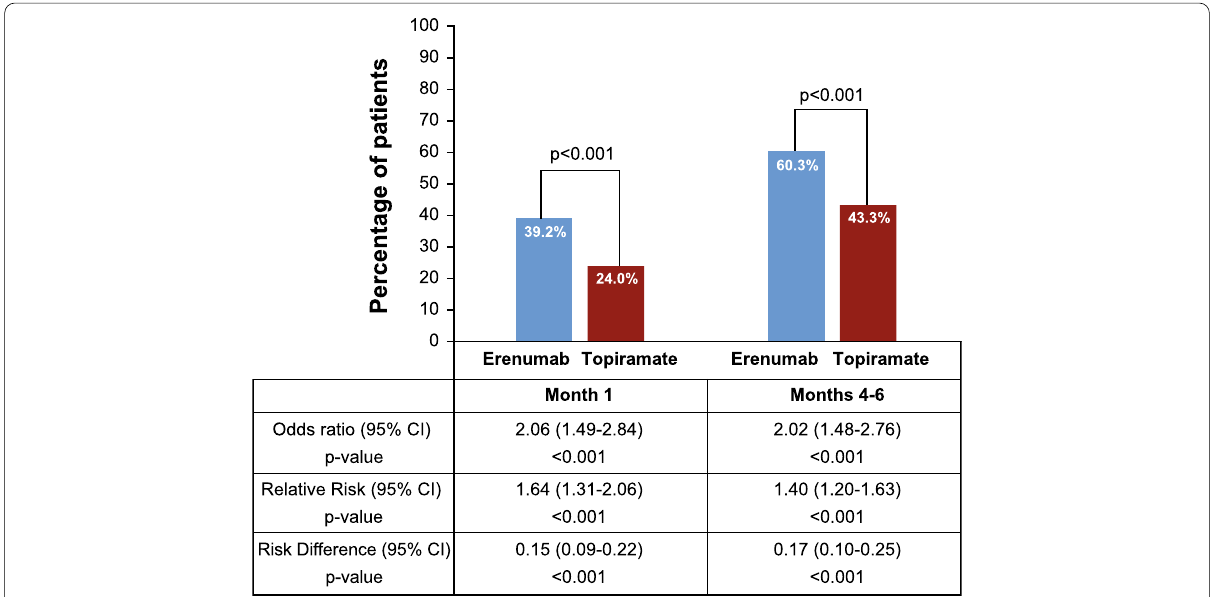
Fig. 2 Proportion of patients who achieved at least a 50% reduction in MMD (post hoc